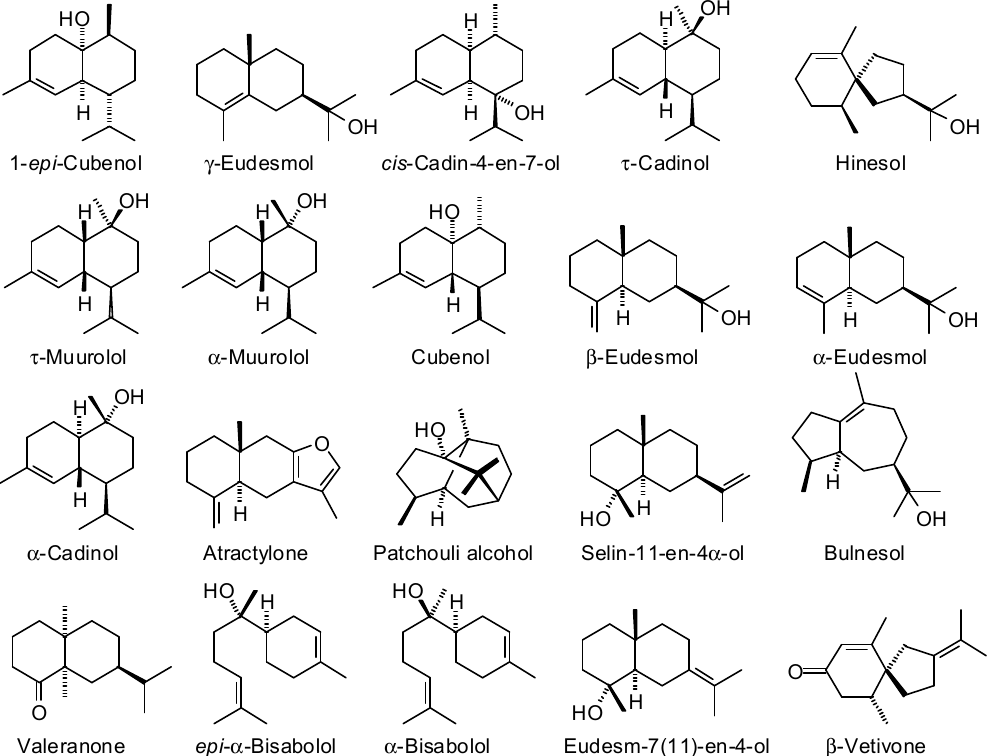
Figure A3. Major oxygenated sesquiterpenoids found in Neotropical Piper species.